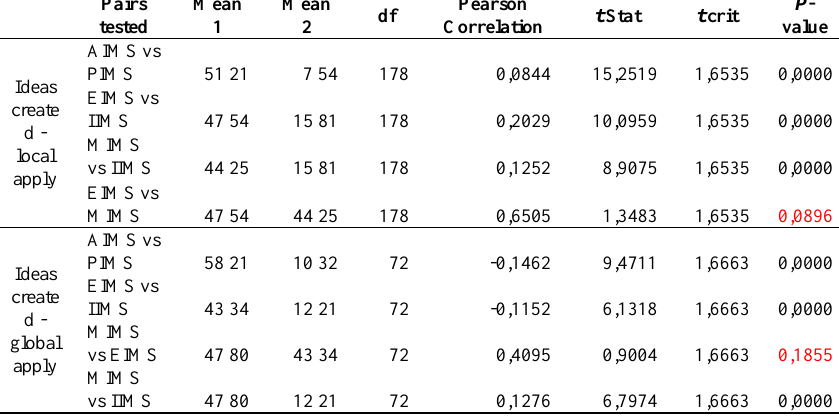
Table 6. t -tests for pairs of average ideas created IMS and apply